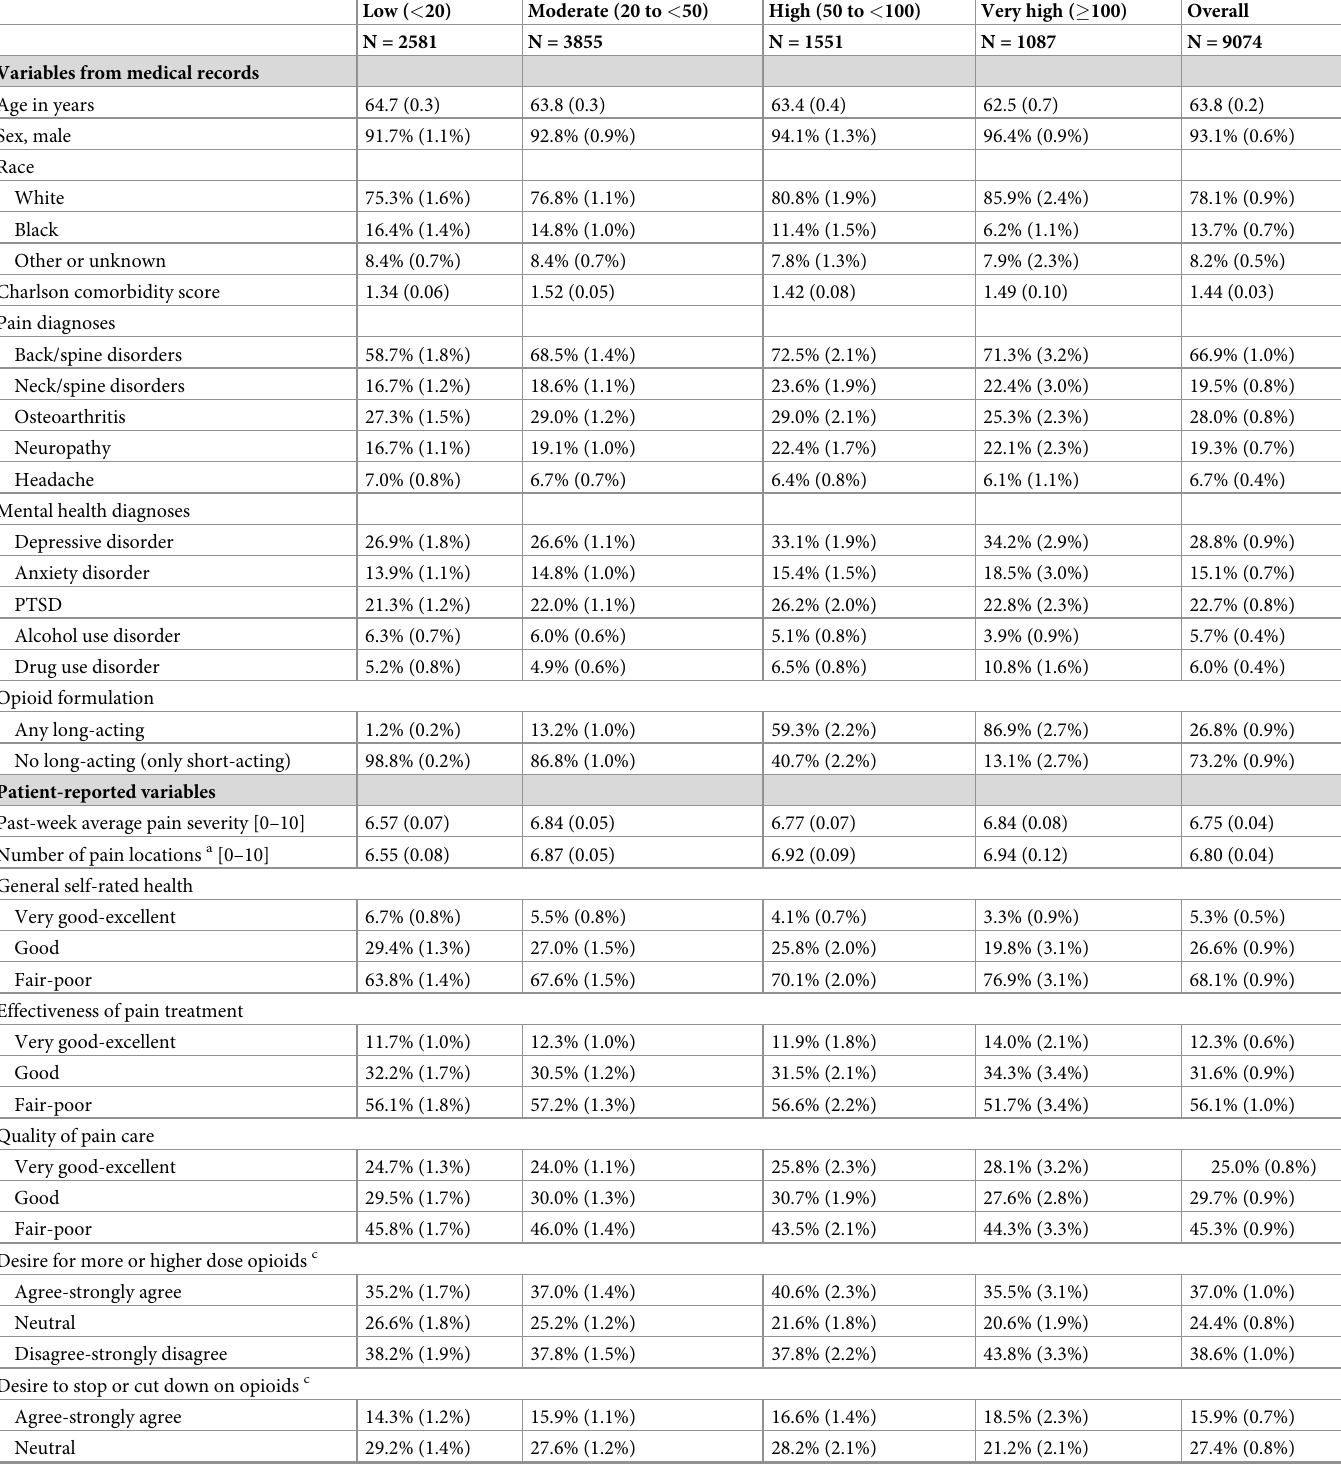
Table 3. Patient characteristics and patient-reported measures by opioid daily dosage category in 6 months before the index date (n =